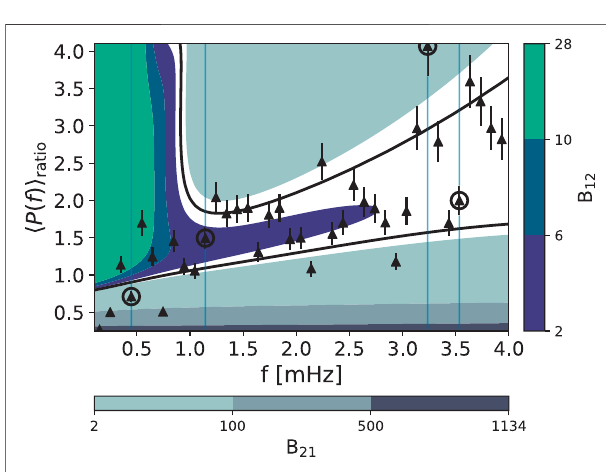
FIGURE9| FilledcontourwiththedistributionofBayesfactors, B RA and B AR , over the two-dimensional data space D . Solid lines connect points with p ( D | M R ) (cid:2) p ( D | M A ) (Bayes factor zero). The computations are performed overagridofpoints( N f =80, N 〈 P ( f ) 〉 =155)overtheranges f ∈ [0.05,4] ratio and 〈 P ( f ) 〉 ratio ∈ [0.25, 4.1]. The priors are p ( ξ E ) ~ G ( 1 . 9 , 0 . 3 ) for M R and p ( ξ E ) ~ G ( 4 . 3 , 0 . 6 ) ; p ( R 0 ) ~ G ( 0 . 5 , 0 . 02 ) for M A . Triangles represent CoMP data. Following Kass and Raftery (1995), the evidence in favour of a model i in front ofanalternative j isinconclusiveforvaluesof2log( B ij )from0to2;positive from2to6;strongfrom6to10;andverystrongforvaluesabove10.Adapted from Montes-Solís and Arregui